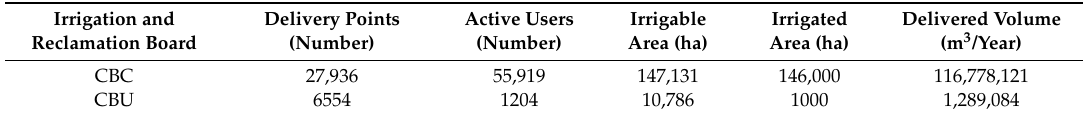
Table 3. Main characteristics of CBC and CBU irrigation supply structures (mean 2011–2014). Irrigation and Reclamation